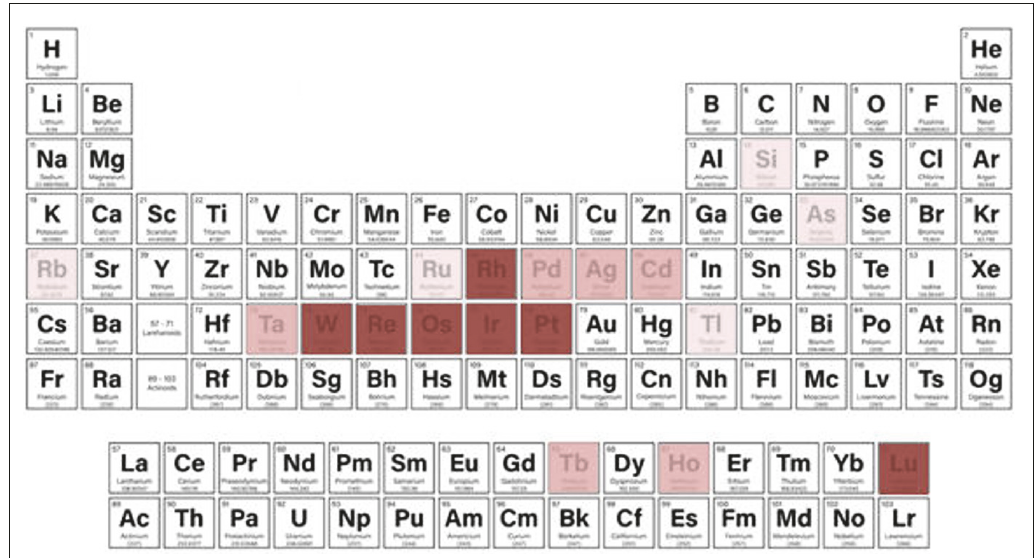
Figure 16: Effective inelastic scattererslabeled on the periodic table. Their relative efficiencyin shifting and broadening the neutron flux peak in the JHR reflector towards lower energies and their ability to cut off the spectrum thermal component are